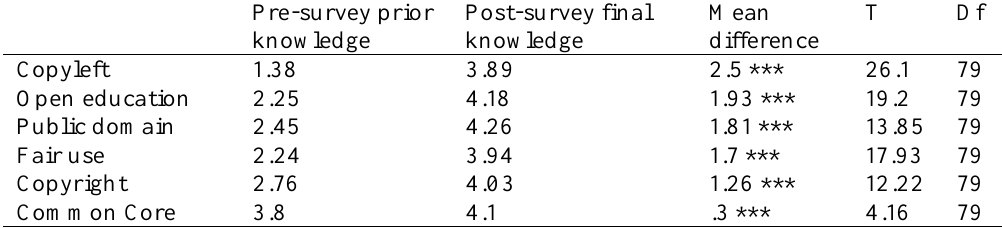
Comparison of Pre-Survey Prior Knowledge and Post-Survey Final Knowledge Pre-survey prior